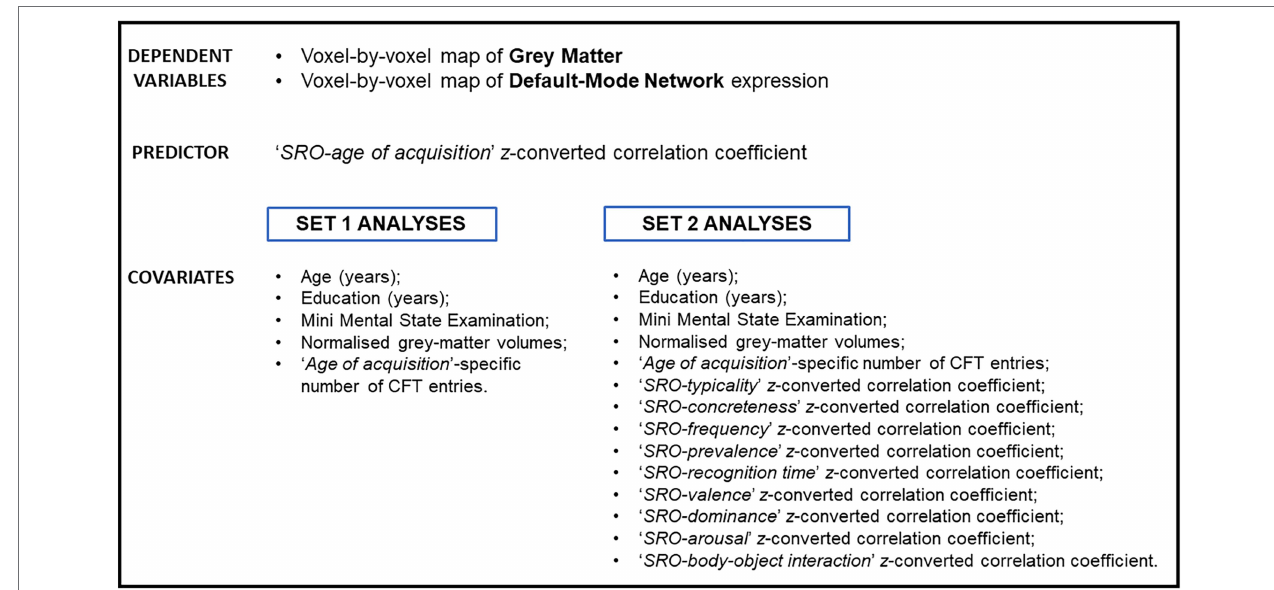
FIGURE 3 | List of variables included in the inferential models of this study. The ‘SRO-age of acquisition’ correlational feature was used as example in this